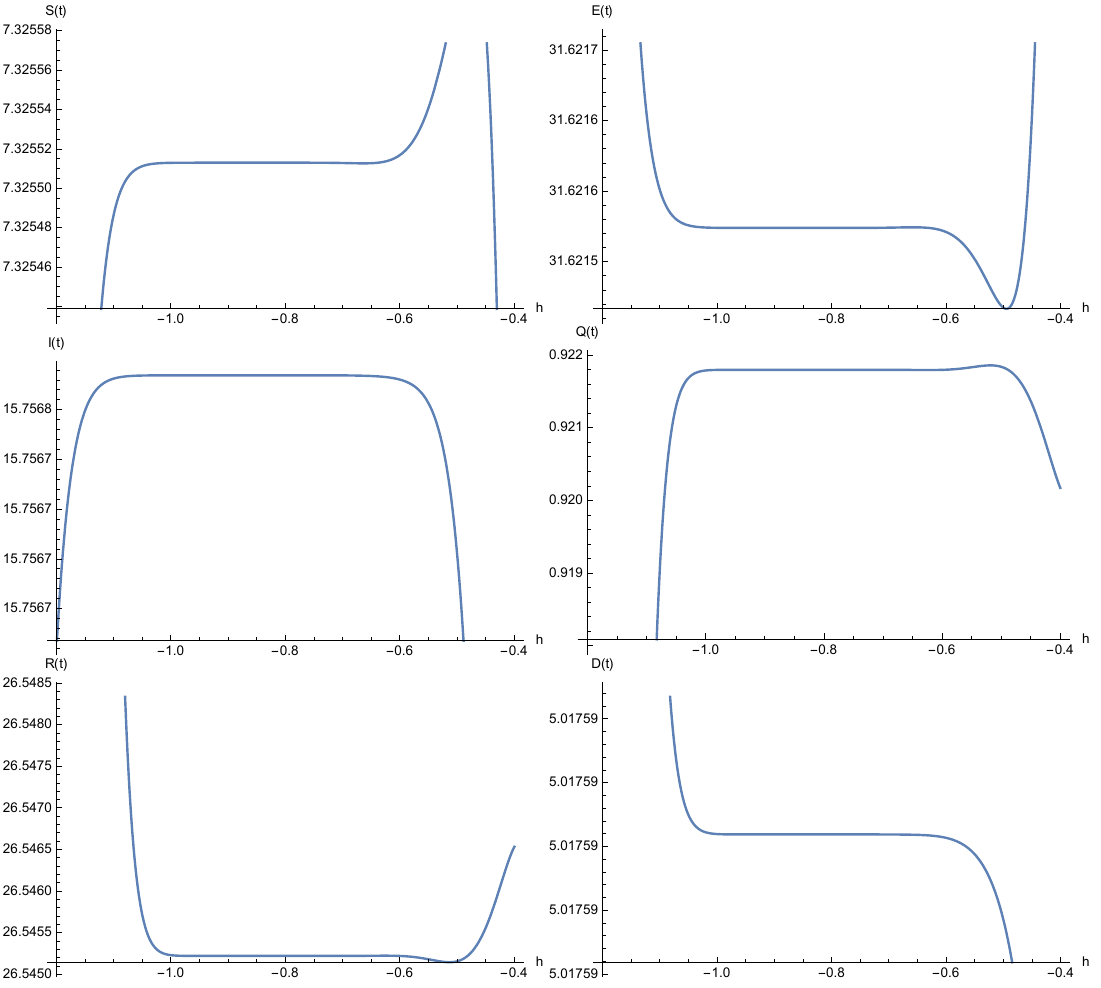
Figure 2. The ¯ h -curves of the approximate solutions obtained form HATM for t = 0.2 and m =